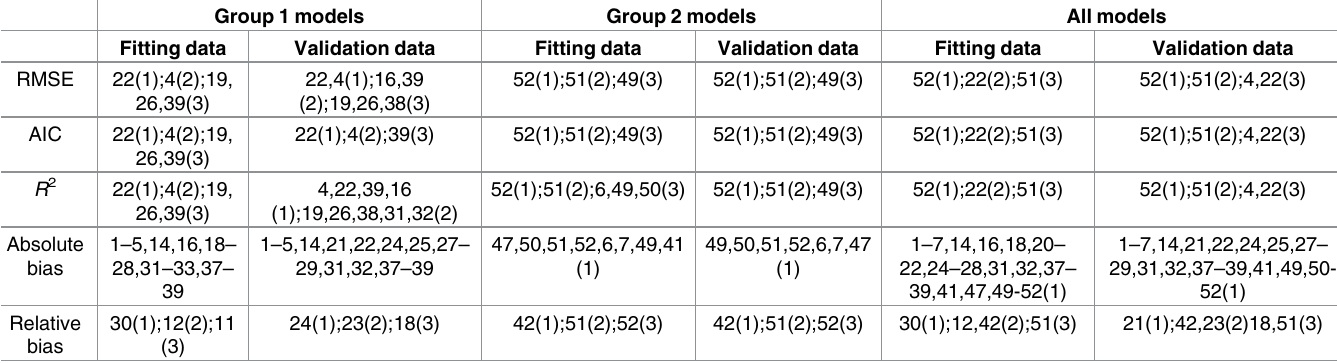
Table 5. Model ranking based on performance. doi: